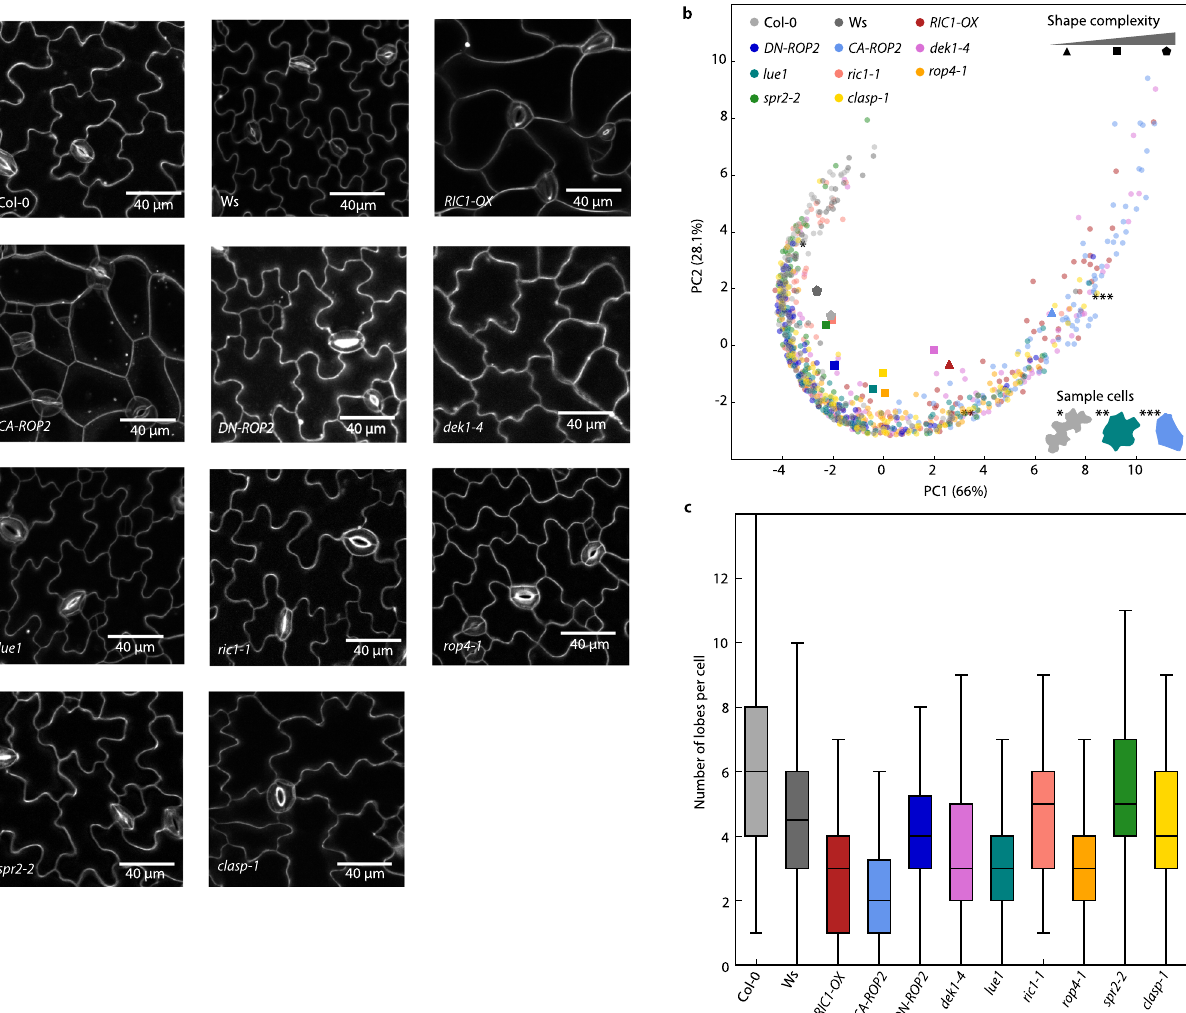
Fig. 7 Comparison of pavement cells based on visibility graphs distinguishes Arabidopsis wild-type and genetically modi fi ed lines. a Images of LTi6b- GFP expressing Arabidopsis wild-type (Col-0, WS) and genetic lines ( RIC1-OX , CA-ROP2 , DN-ROP2 , dek1-4 , lue1 , ric1-1 , rop4-1 , spr2-2 , clasp-1 ). For all genetically modi fi ed lines we captured six images, for DN-ROP2 we captured four images. b PCA of distances ( n = 80 pavement cells per sample from different images) between pavement cells of wild-type Col-0 and WS (light gray and dark gray, respectively) and expression lines: RIC1-OX (red), CA-ROP2 (light blue), DN-ROP2 (dark blue), dek1-4 (pink), lue1 (teal), ric1-1 (salmon), rop4-1 (orange), spr2-2 (green), and clasp-1 (yellow). The circles correspond to selected cells, and the other shapes denote the center of mass for the corresponding expression lines. We used triangles for genetic lines with simple cell shapes ( RIC1-OX , DN-ROP2 ), pentagons for very complex shapes (Col-0, Ws), and squares for shapes in between. Sample cells for Col-0 (light gray), CA- ROP2 (light blue), and lue1 (teal) and are shown in the lower right corner. c Boxplot of a number of detected lobes for wild-type and mutants (80 pavement cells per sample). Boxplots are shown with median (horizontal line), 25th, and 75th percentiles (box edges), and 1.5-fold of the interquartile range (whiskers). Source data are provided as a Source Data fi